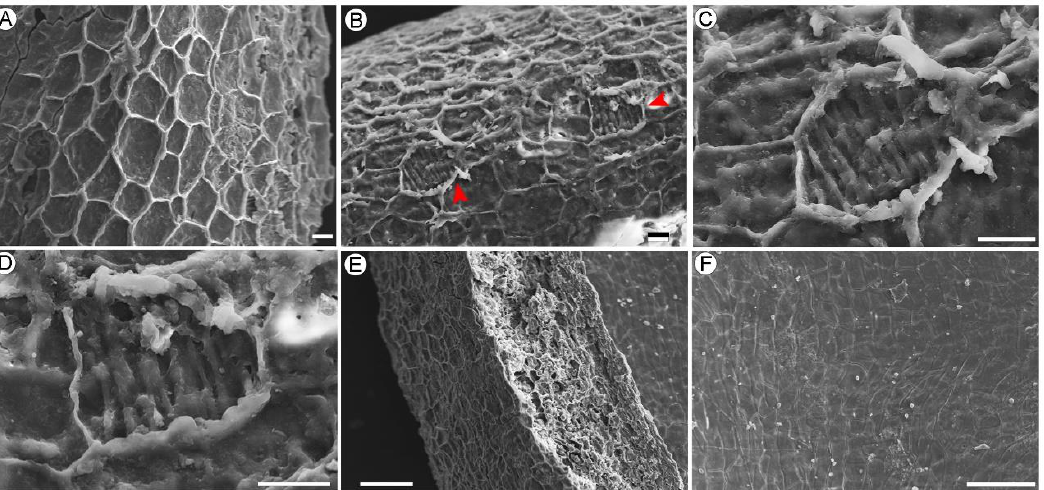
Figure 4. Scanning electron microscopic image of the pericarp of Ceratophyllum demersum L., GP440. ( A – D ) The outer surface of the exocarp with polygonal cells, red arrows show the parallel partitions. ( E ) Lateral view, showing the fiber structure of the pericarp. ( F ) The inner surface of the endocarp with rectangular cells. Scale Bars = 20 µ m ( A , B ), 10 µ m ( C , D ), 100 µ m ( E , F ).